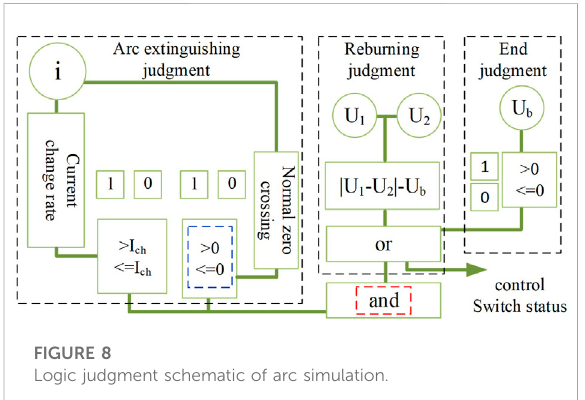
FIGURE 8 Logic judgment schematic of arc simulation.